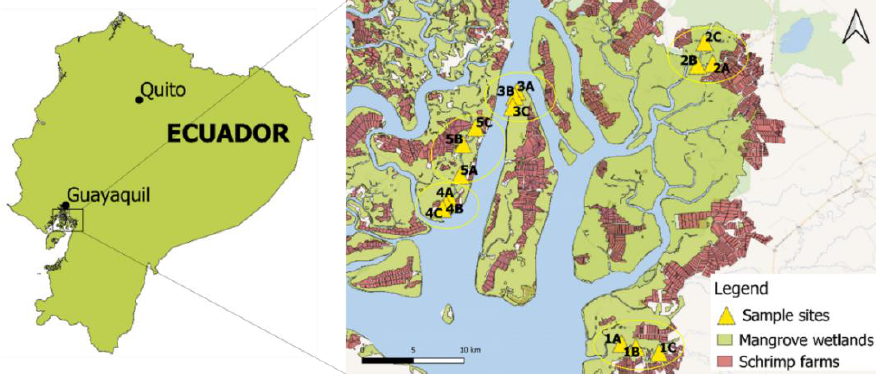
Figure 1. Map of the study area with indication of the sampling sites in Guayas Estuarine Basin, Ecuador.